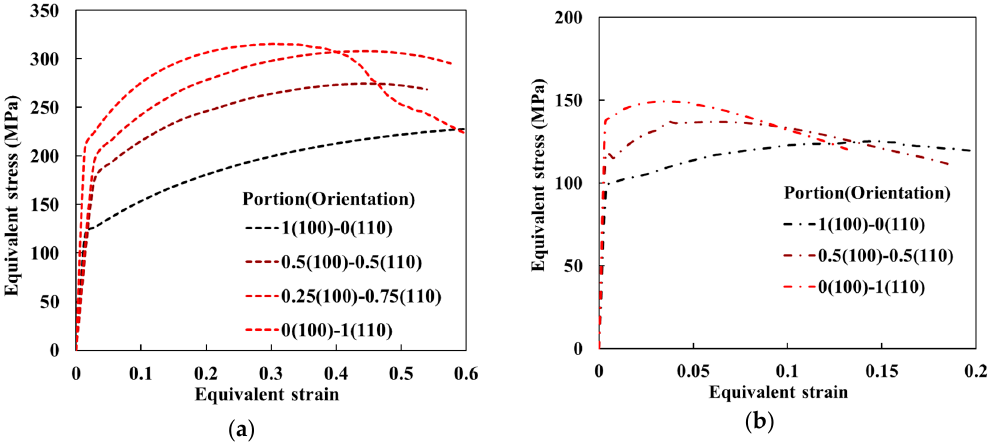
Figure 7. Stress-strain curves of (110)-(100) bi-crystals with different fraction of (100) portions for the stress triaxiality ( a ) 1, and ( b ) 3. The orientations are denoted in the bracket and the number represents the volume fraction. For example, 0.5 (100) means 50% of (100) orientation.